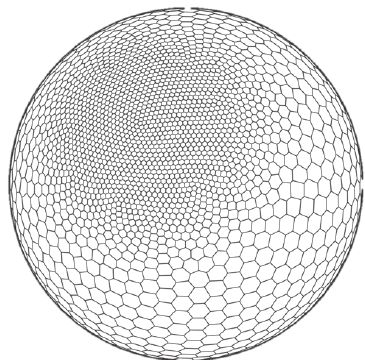
Figure 3. A constrained centroidal Voronoi tessellation mesh with localized grid density that could be employed in the MPAS